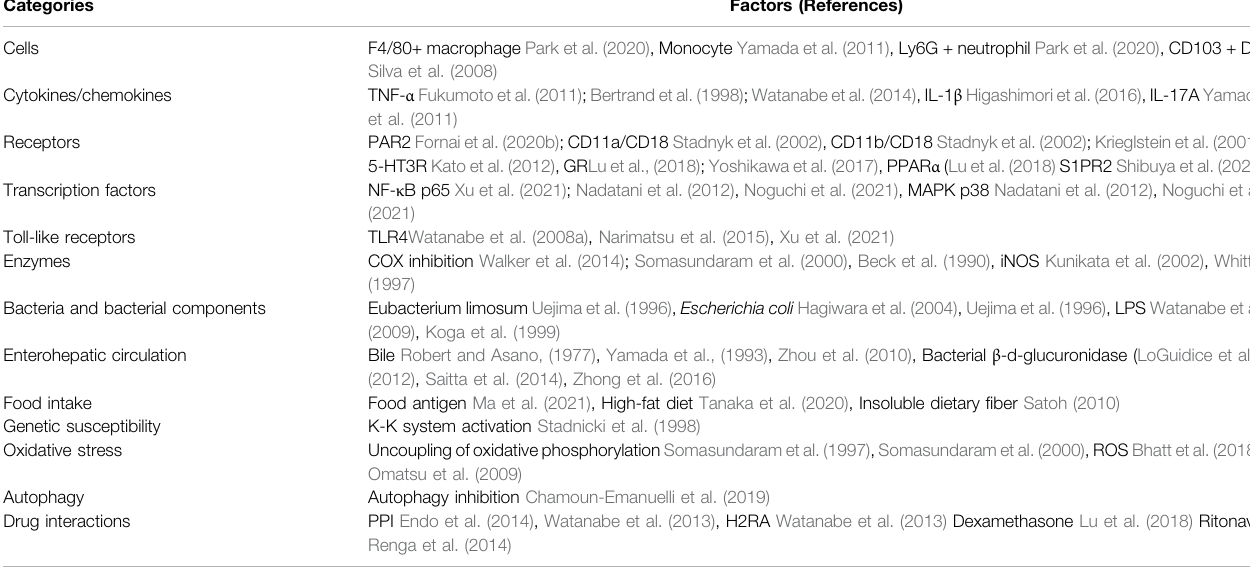
TABLE 2 | Pathogenesis of NSAID-associated small intestinal